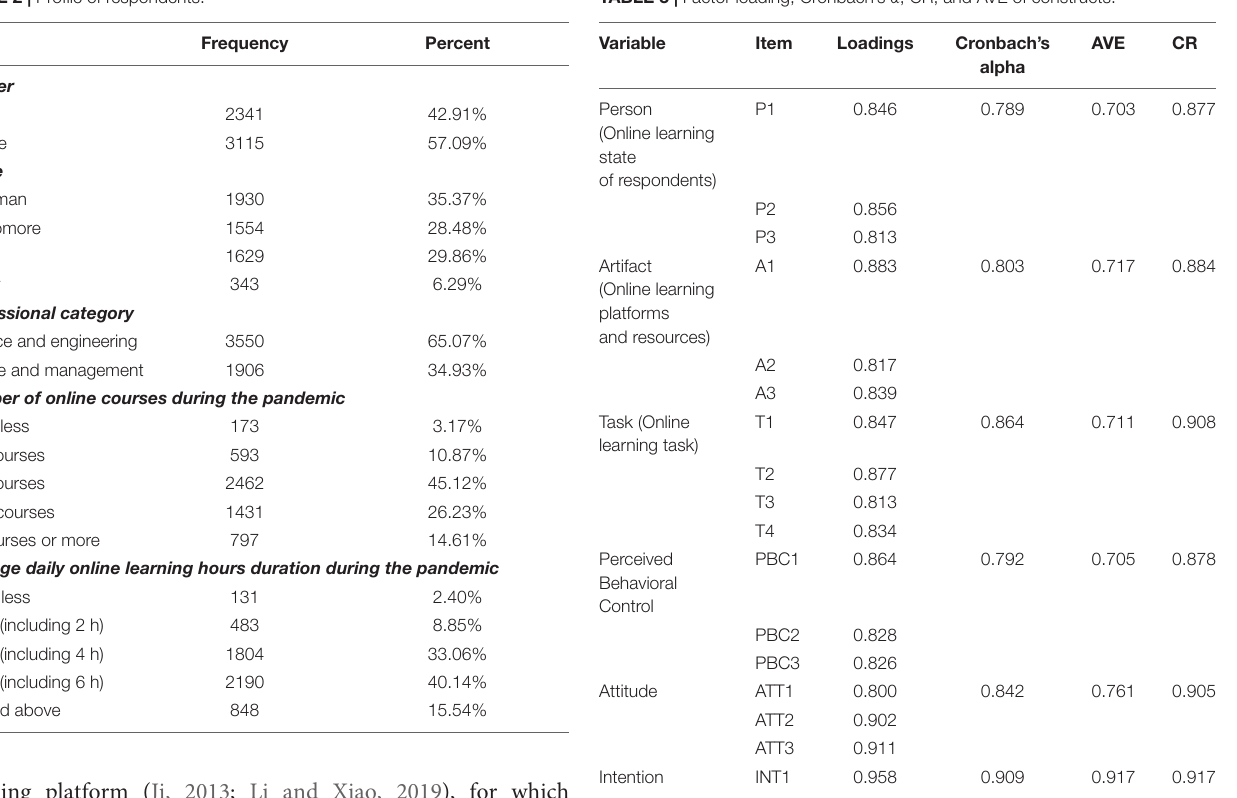
TABLE 2 | Profile of respondents. TABLE 3 | Factor loading, Cronbach’s α , CR, and AVE of